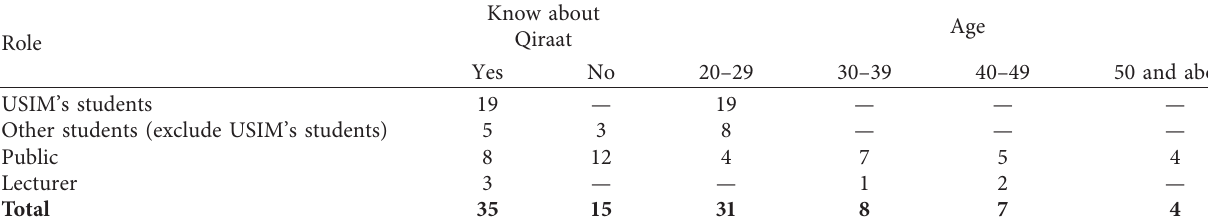
Table 1: The participants that have been involved in the evaluation.